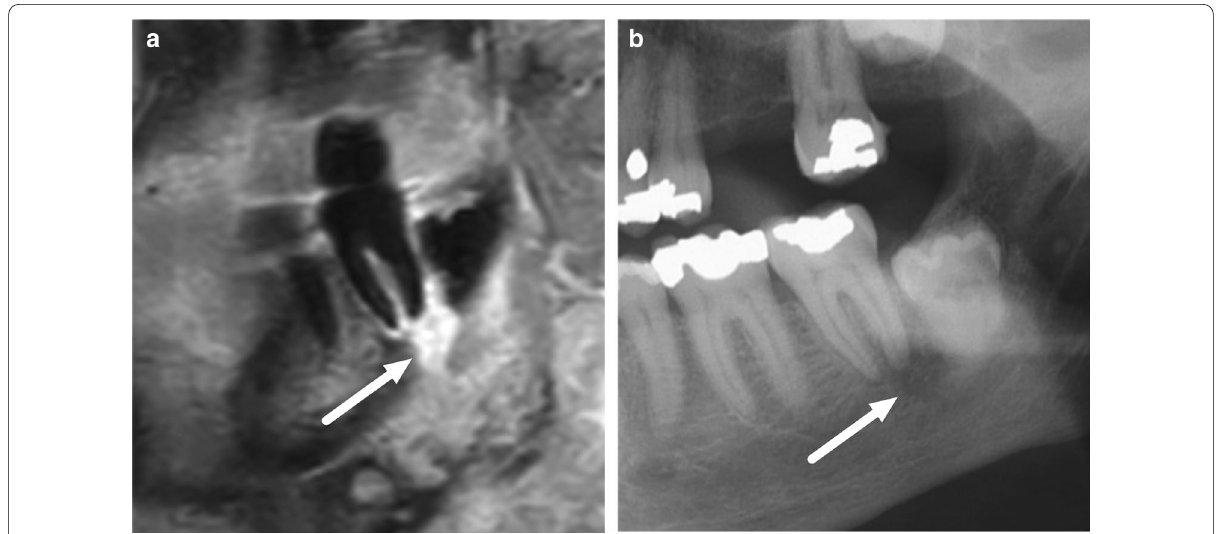
Fig. 20 Periapical enhancement (arrow) at the tooth responsible for the neck infection, on a sagittal fat-suppressed post-contrast T1-weighted image ( a ). Radiography showed corresponding periapical radiolucency (arrow) consistent with an infection ( b